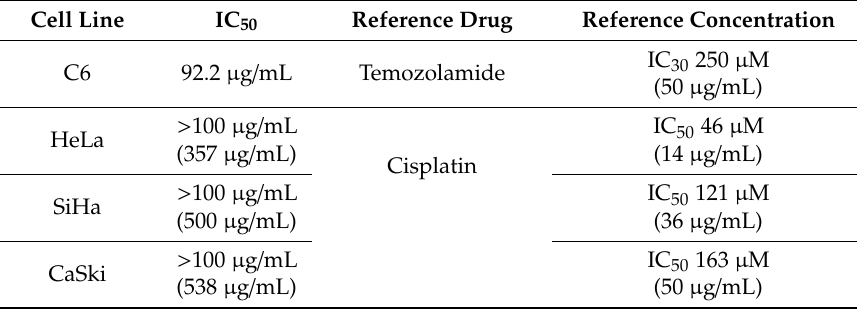
Table 3. Cytotoxic e ff ect of EEP on several cancer cell